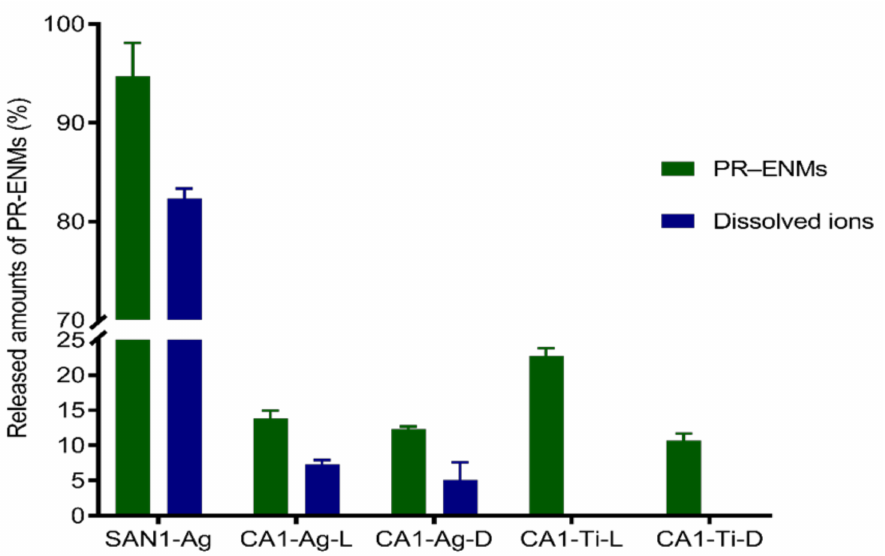
Figure 6. The amounts of SAN1 and CA1-released nAg and released Ag ions; L and D denote light and dark conditions,